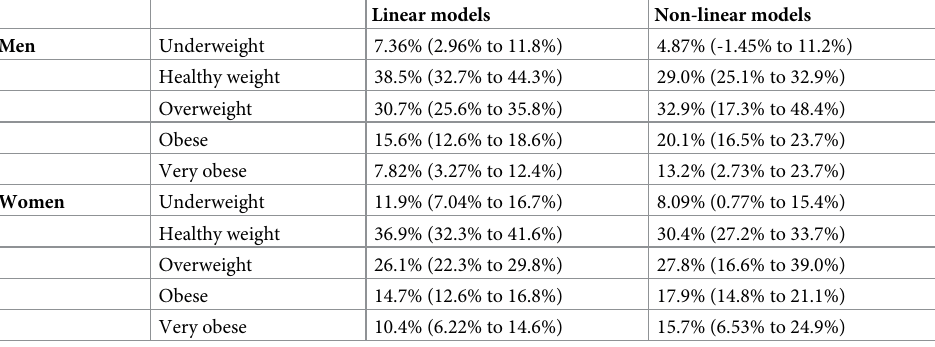
Table 3. Predictions of obesity prevalence in 2035, with the linear and non-linear